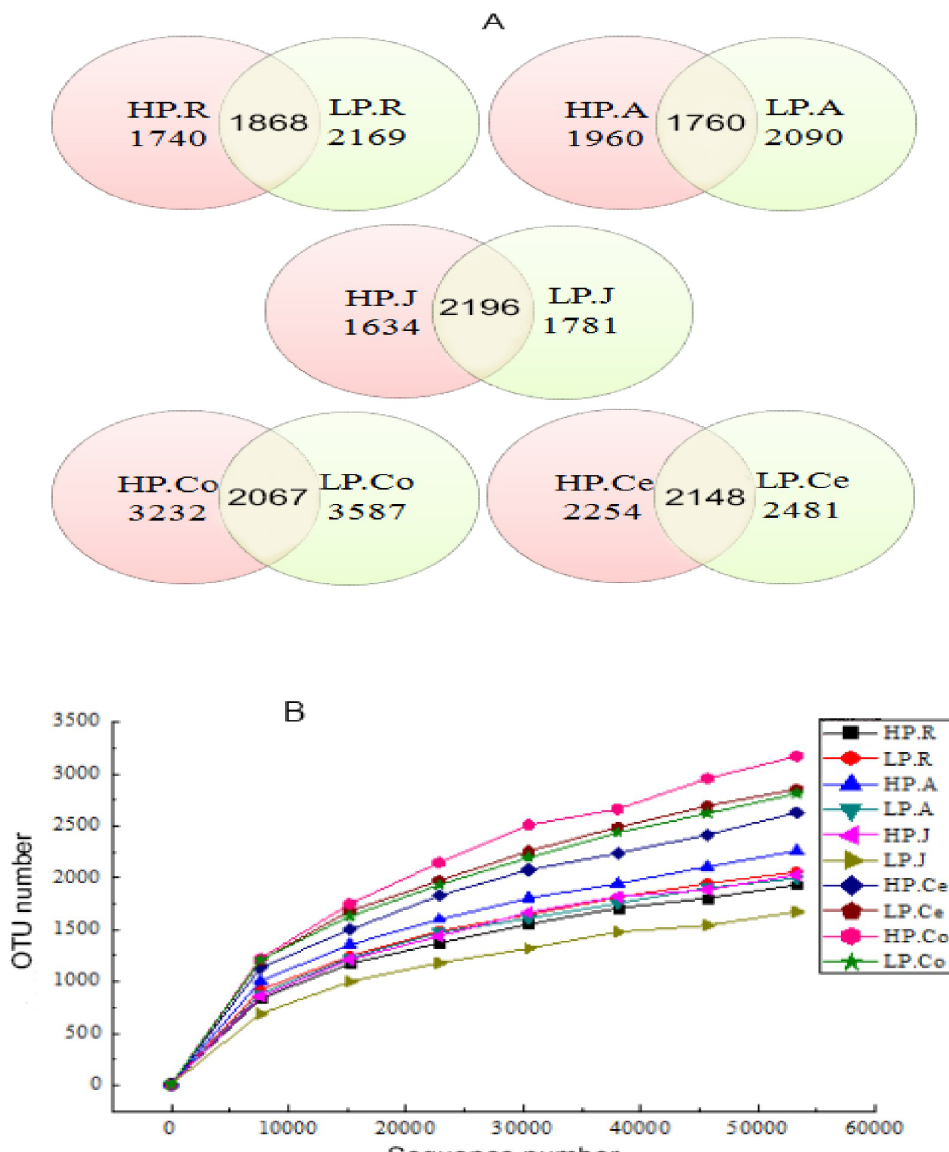
Fig 1. A: Venn diagram representation of the shared and exclusive OTUs. B: Rarefaction curves of each group. The rarefaction analysis was conducted at 97% sequence identity, and each curve represented one individual gastrointestinal sample of goats (n = 8). HP.R: rumen of HP; LP.R: rumen of LP; HP.A: abomasum of HP; LP.A: abomasum of LP; HP.J: jejunum of HP; LP.J: jejunum of LP; HP.Co: colon of HP; LP.Co: colon of LP; HP.Ce: cecum of HP; LP.Ce: cecum of